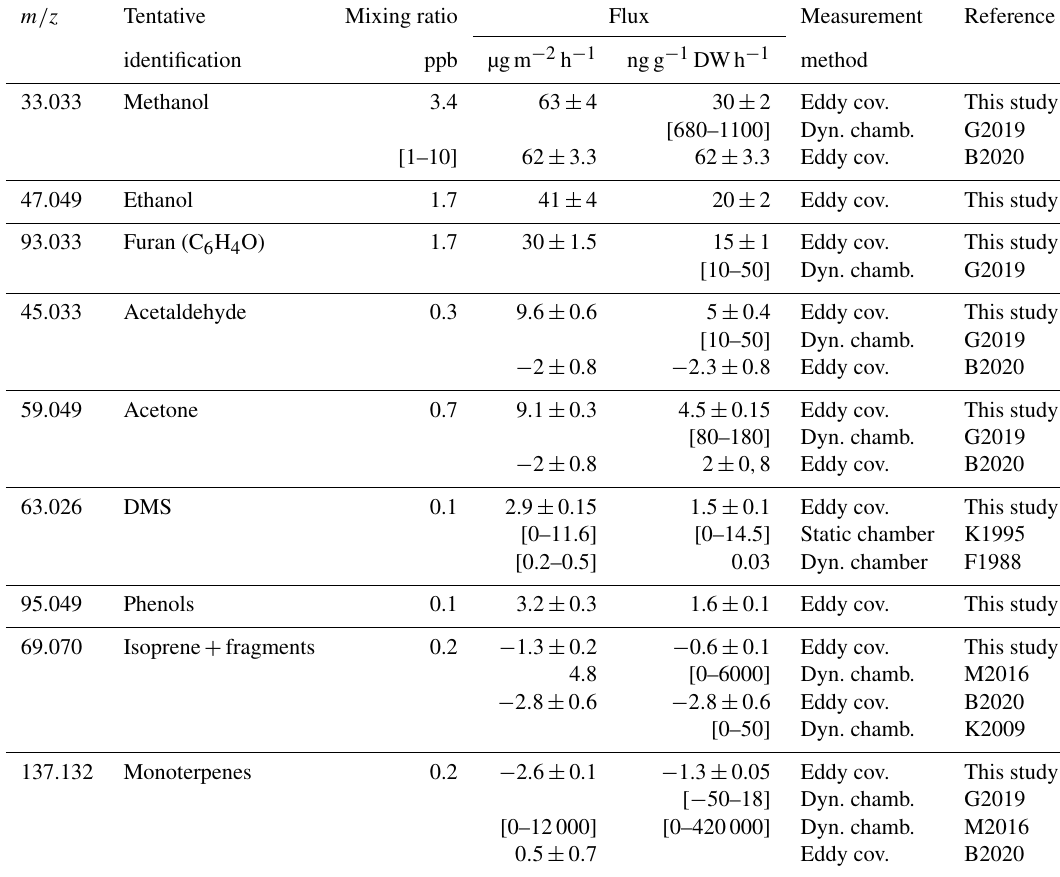
Table 1. Fluxes and mixing ratios of the 9 most emitted VOCs found in this study, together with isoprene and monoterpenes, compared to literature values using different methods of measurement. VOC fluxes measured by eddy covariance refer to the whole ecosystem including soil and are expressed per square metre of ground surface. Fluxes from chamber measurements refer to projected surface and dry weight (DW) of the enclosed aboveground organ of wheat. Means ± standard errors and [min–max]